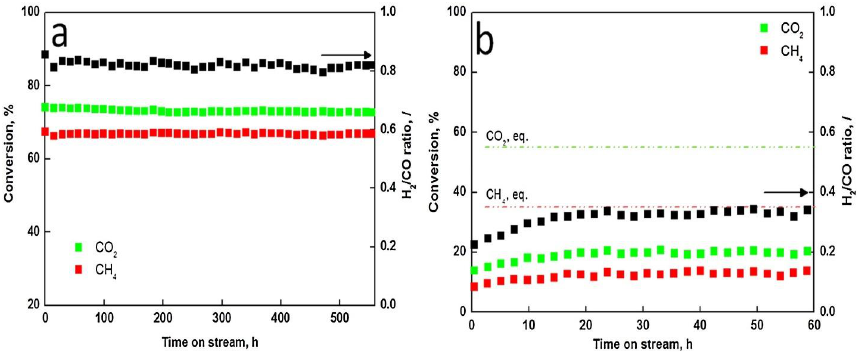
Figure 6. CH 4 , CO 2 conversion and H 2 /CO ratio of 3 wt % NiCo/CeO 2 -ZrO 2 at 750 °C and ( a ) 1.2 bar and ( b ) 20 bar. Reproduced with permission from [57].